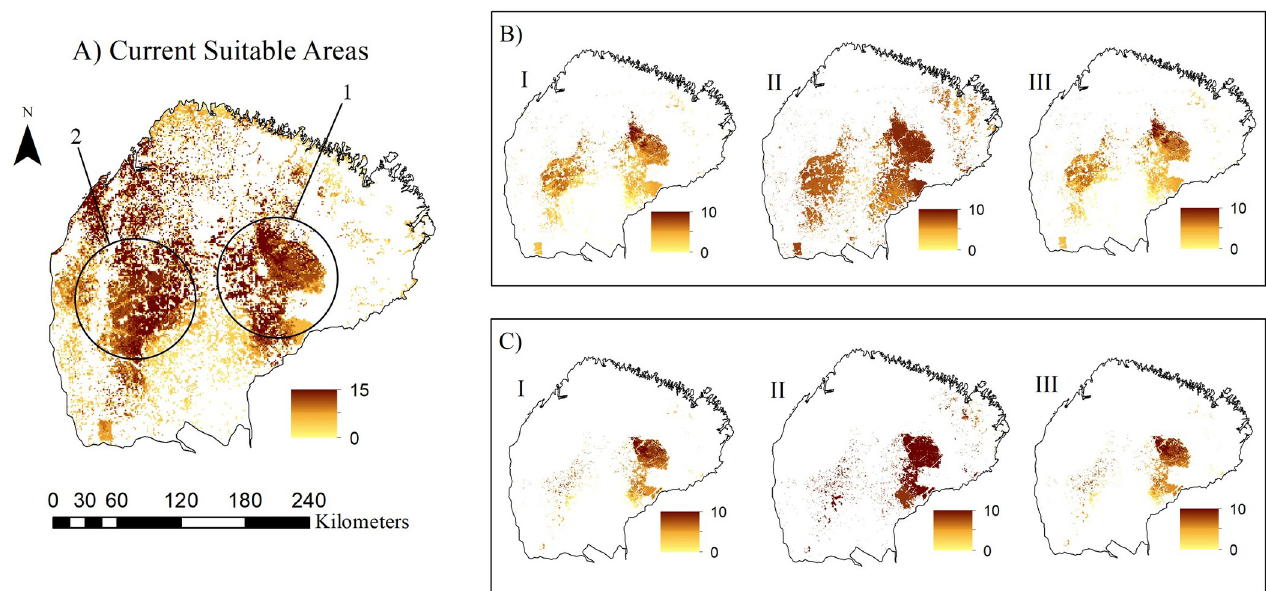
Fig 3. Maps of the potential distribution of endemic bird species from the Bele´m Area of Endemism. 1—“Gurupi Mosaic”; 2—“Rio-Capim” watershed. (A) represents the current climate suitability areas, while (B) represents the mitigation scenario, and (C) the Business-as-usual scenario. Regarding different dispersion contexts, sections (I), (II), and (III) demonstrate the Unlimited Dispersal, Limited Dispersal, and No Dispersal scenarios, respectively. Dispersal scenarios were applied to the projections. The mitigation and business-as-usual scenarios applied are projections constructed from perspectives of greenhouse gas emissions, and investments in conservation policies. Colors that vary between yellow and brown represent the number of species per cell in the projections. Both projections of forest remnants have been extracted from the SimAmazonia database [26].